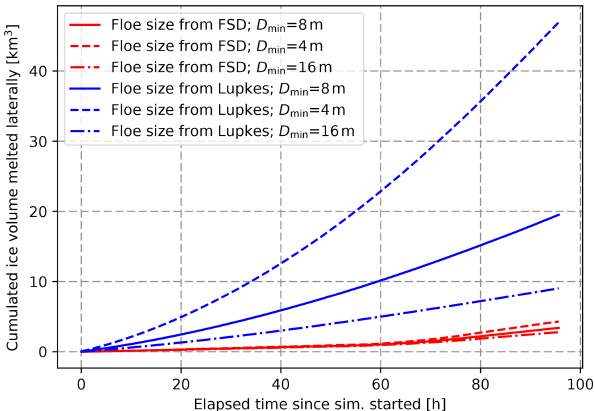
Figure 5. Temporal evolution of the sea ice volume loss due to lat- eral melt integrated over the whole domain for simulations similar to the one presented in Fig. 4 but for different values of D min . The two colours correspond to the two lateral-melt parameterizations used in this